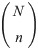
Metabolisms viable on different carbon sources and genotypic differences among them.
a) Number of viable metabolisms. Black circles (vertical axis) indicate the total possible numbers (Nn) of metabolisms of a given size n (horizontal axis, N = 51, 0 ≤ n ≤ 51). Colored data points indicate the number of metabolisms viable on the single carbon sources indicated in the legend. b) Fraction of metabolisms viable on different carbon sources. Note the logarithmic vertical scale. Data on glucose in a) and b) has been previously published [19]. c) Genotype network diameter. Black circles indicate the diameter of genotype space for metabolisms of a given size, which is an upper bound to the diameter of any one genotype network. Colored data points indicate genotype network diameter for metabolisms viable on a single carbon source. Where sets of viable metabolisms comprised more than one connected component, the diameter of the giant component was chosen. At n ≥ 40, all genotype networks have the maximally possible diameter. d). Fraction of metabolisms that contain no disconnected reactions. Colored circles correspond to metabolisms viable on the carbon source specified in the legend and black circles correspond to inviable metabolisms. Data on inviable metabolisms is based on 10000 randomly sampled inviable metabolisms. Interpolation between data points (circles) is linear and displayed as a visual guide.